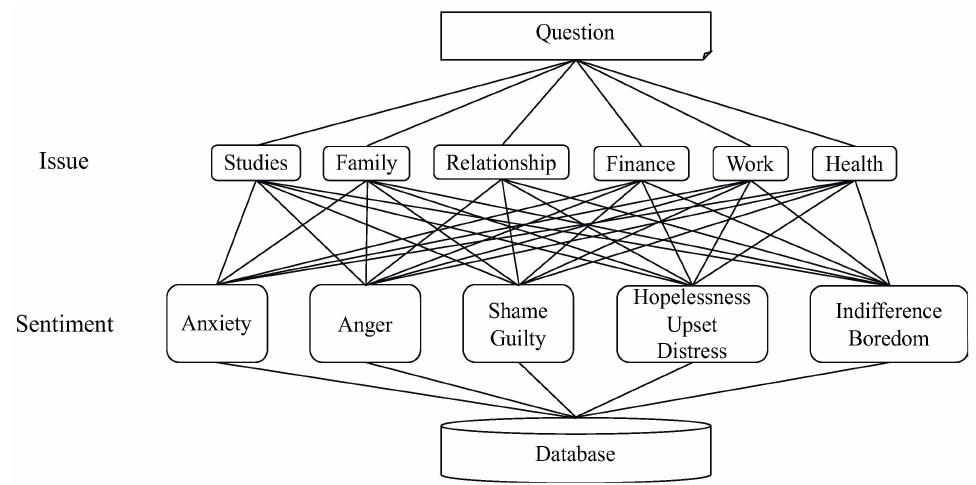
Figure 5. Circular space of the circumplex model.